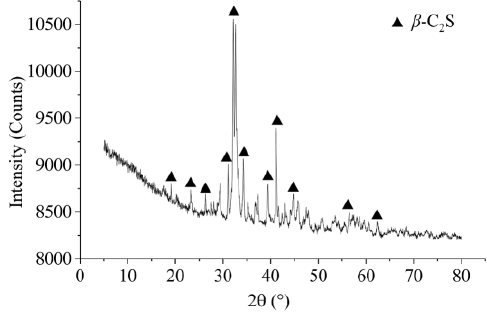
Figure 2. XRD pattern of CSS.